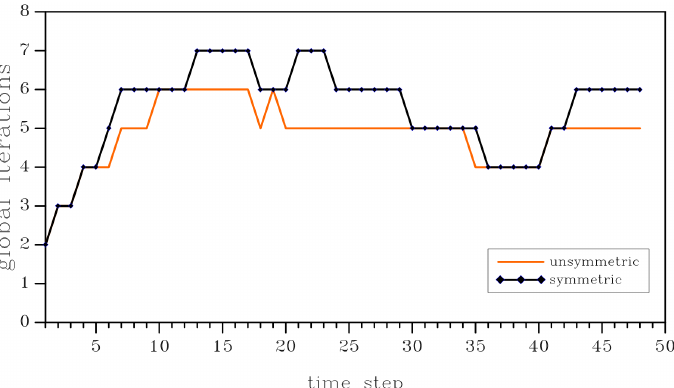
Figure 10. Real case test. Number of nonlinear iterations per time step for symmetric and unsymmet- ric operators.